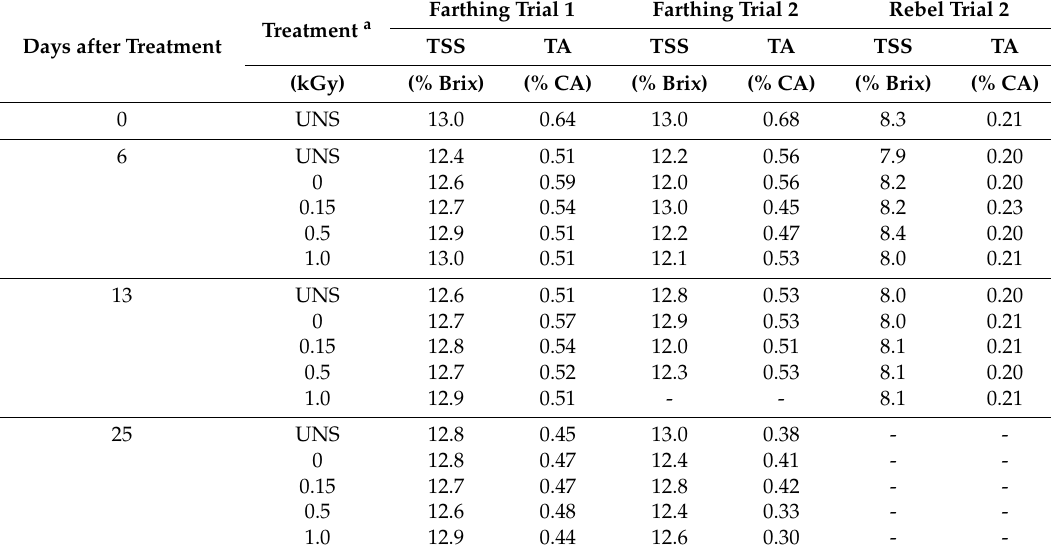
Table 1. Total soluble solids (TSS) content and titratable acidity (TA) of ‘Farthing’ and ‘Rebel’ blueberry fruit subjected to Electronic Cold-Pasteurization TM followed by different cold storage